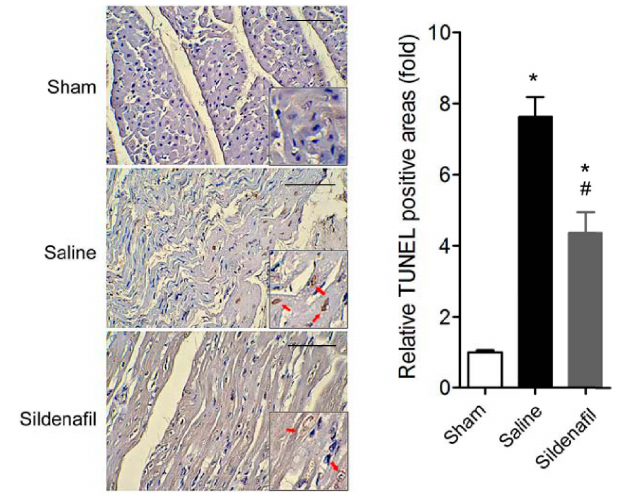
Figure 4. Myocardium apoptosis was assayed by TUNEL. Representative image and quantitative analysis of TUNEL staining on myocardium. * p < 0.05 vs. Sham, # p < 0.05 vs. Saline. n = 6–10 per group. Scale bar: 100 µ m. The red arrows indicate the TUNEL-positive nuclei.